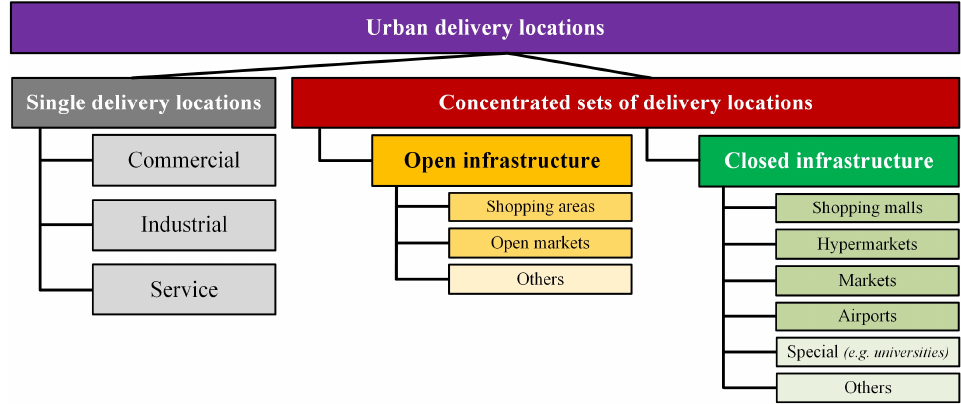
Figure 1. Groups of urban delivery locations [3].